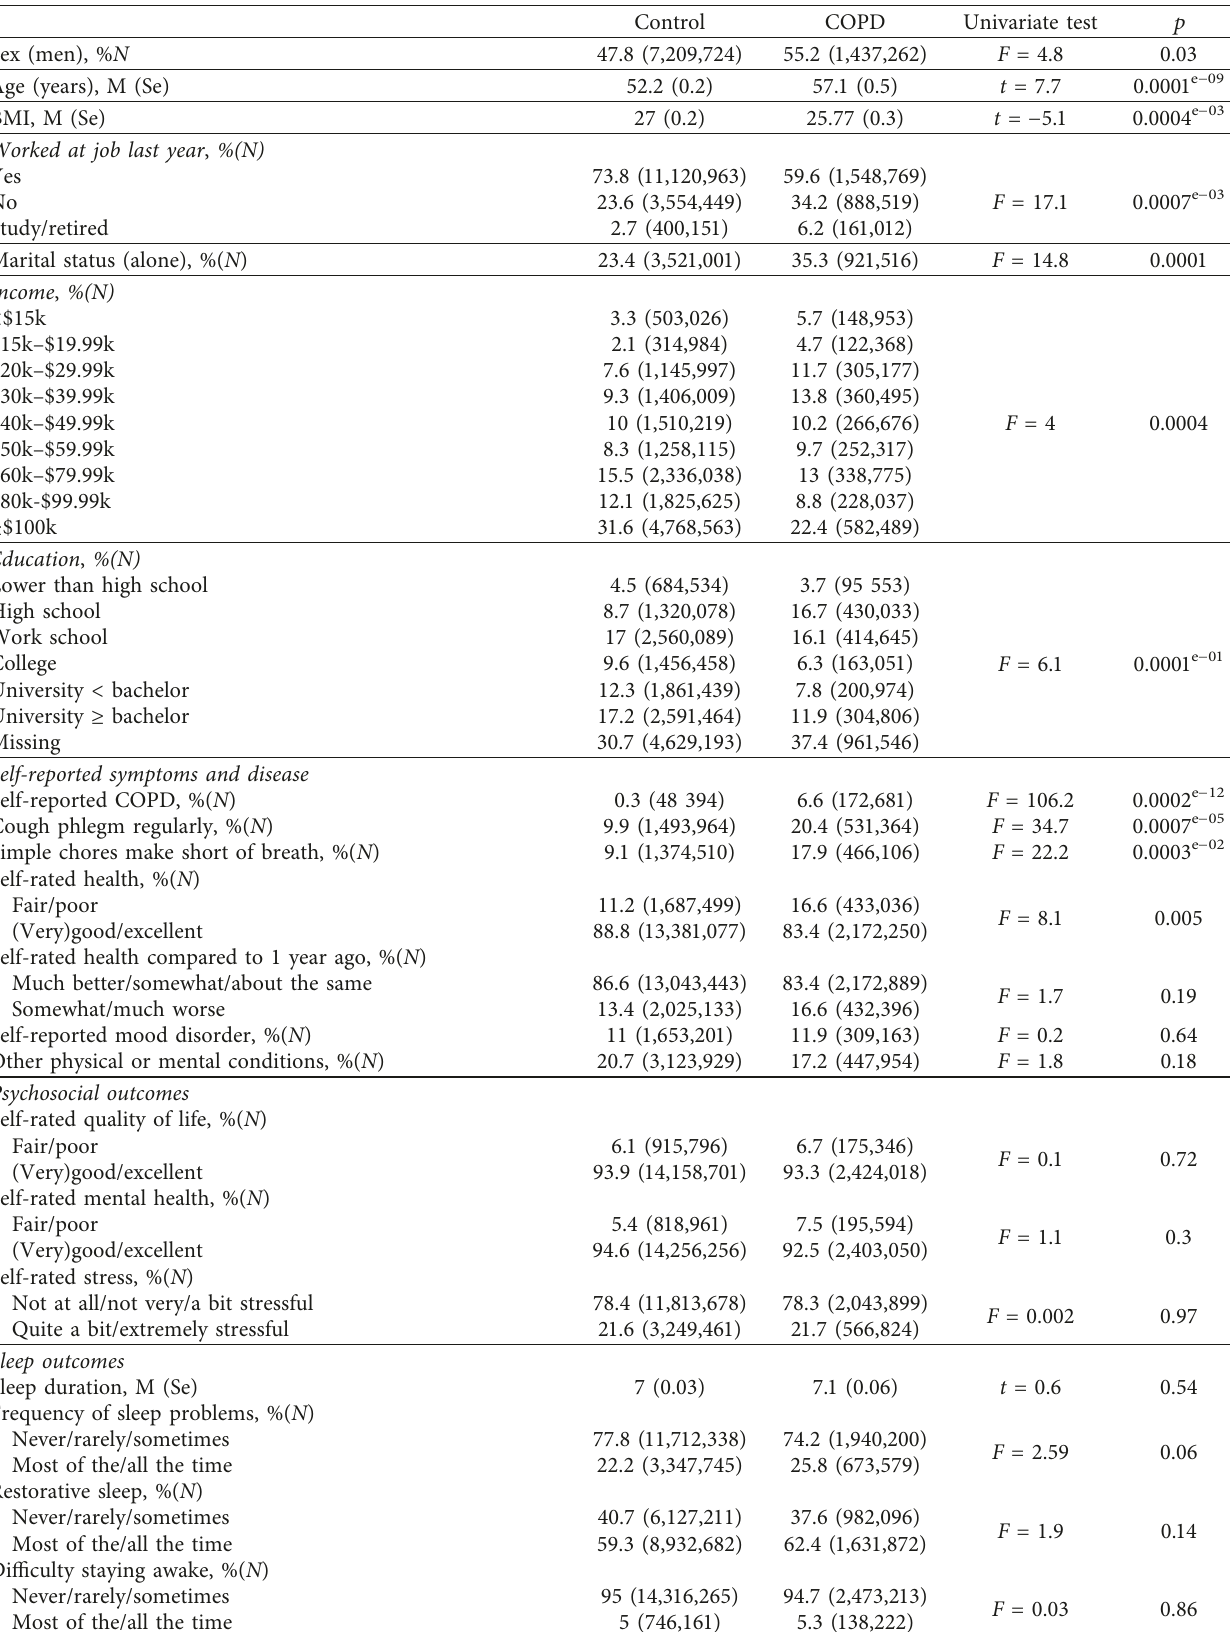
Table 1: Weighted sample characteristics for adults with airflow obstruction consistent with COPD and the comparison